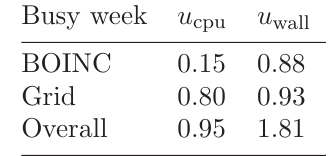
Table 3. BOINC job CPU efficiency: VM vs. Containerization